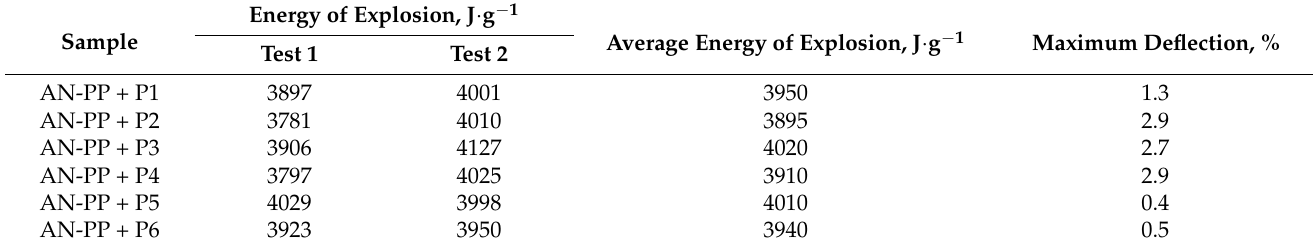
Table 4. The heat of explosion of non-ideal